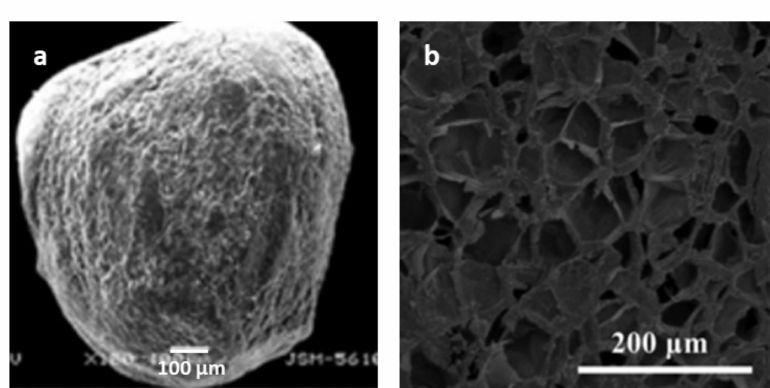
Figure 2. ( a ) SEM image of alginate-cellulose nanocrystals (CNC) microcapsules. Reprinted